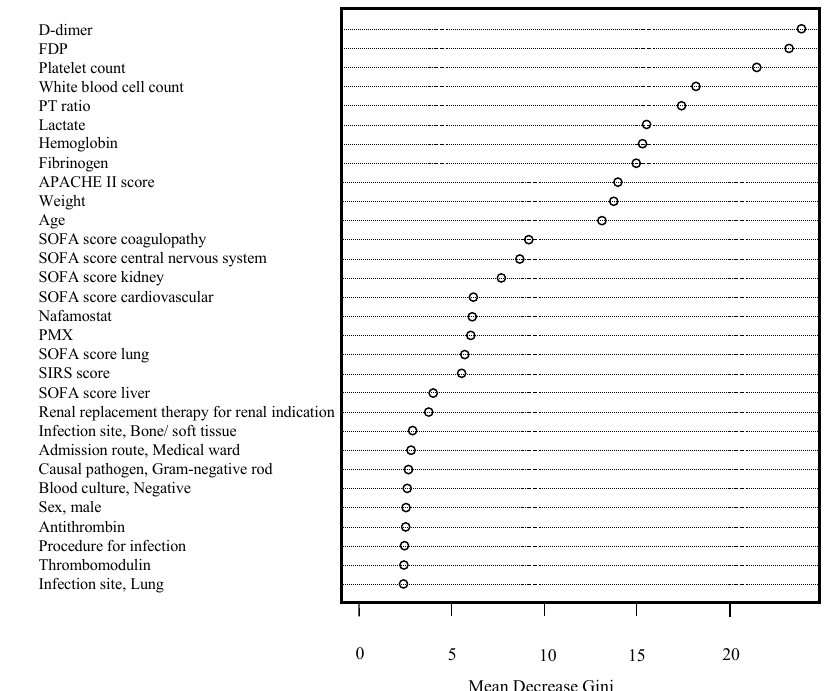
Figure 2. Importance of variables in a random forest plot examined by Gini coefficients. FDP, fibrin/fibrinogen-degradation product; PT, prothrombin time; APACHE, Acute Physiology and Chronic Health Evaluation; SOFA, Sequential Organ Failure Assessment; PMX, polymyxin B hemoperfusion; SIRS score, Systemic Inflammatory Response Syndrome.